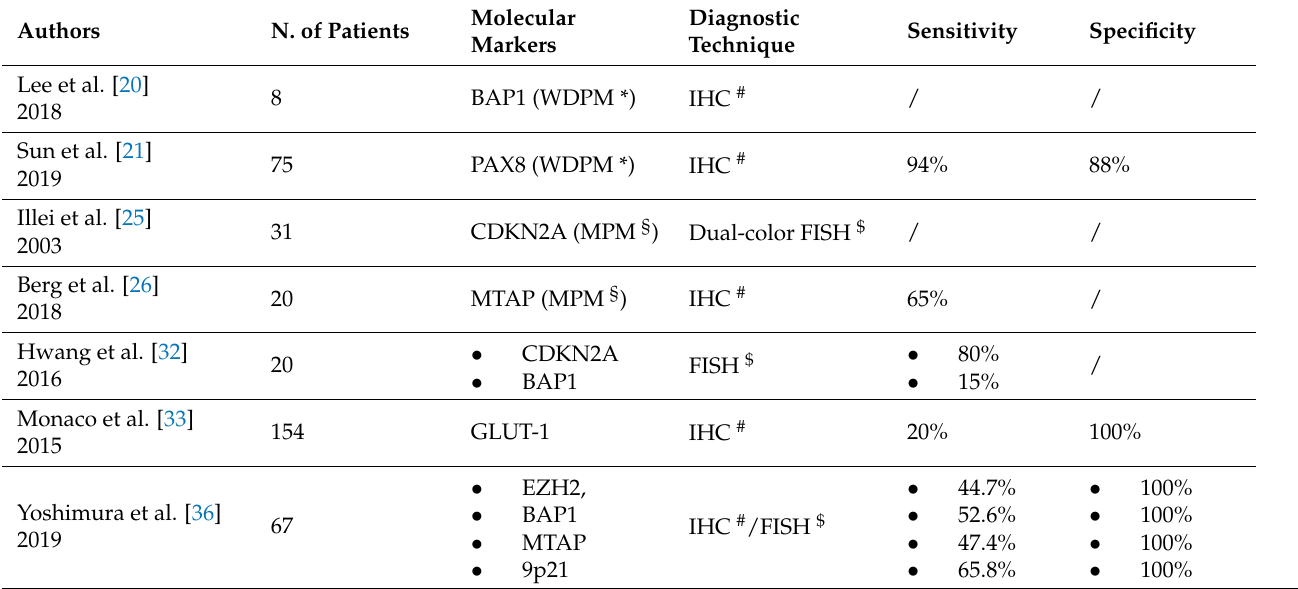
Table 3. Sensitivity and specificity of molecular markers for differential diagnosis of pleural